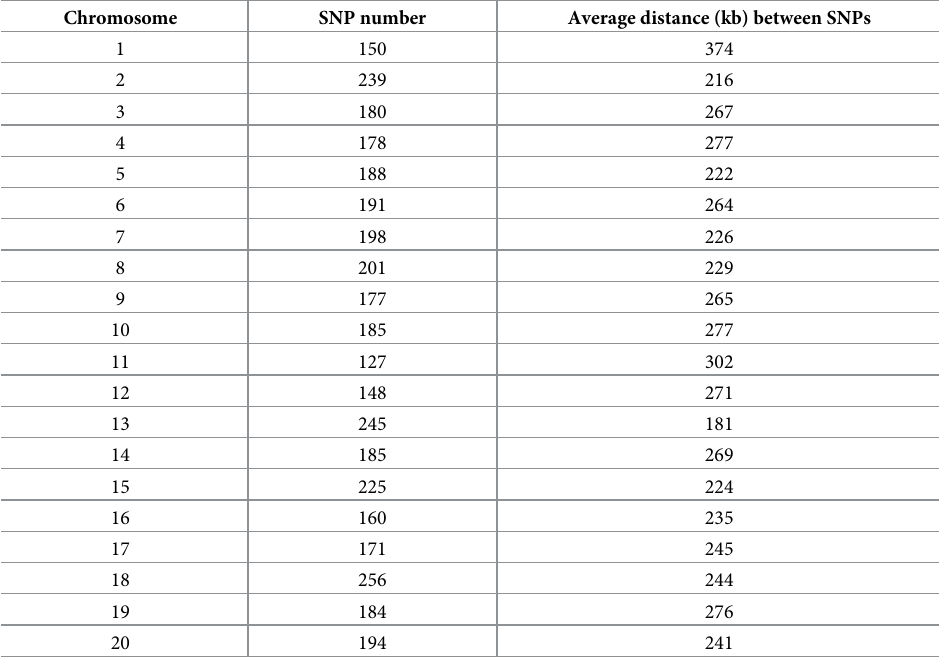
Table 2. SNP profiling used for GWAS for tolerance to SCN infection based on biomass reduction.